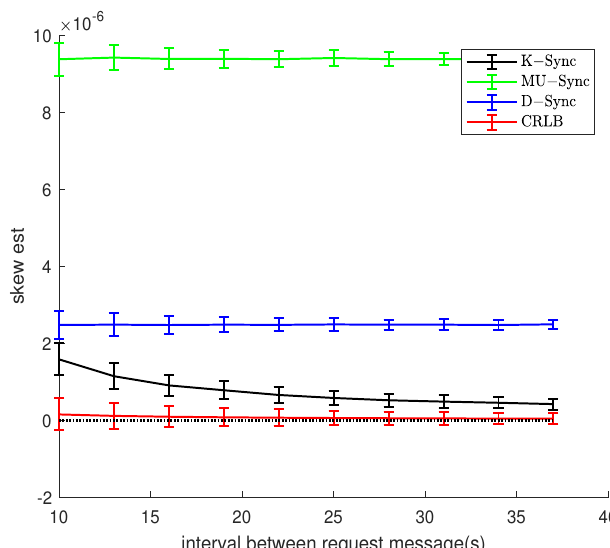
Figure 9. Effect of message exchanges interval (Model 1).